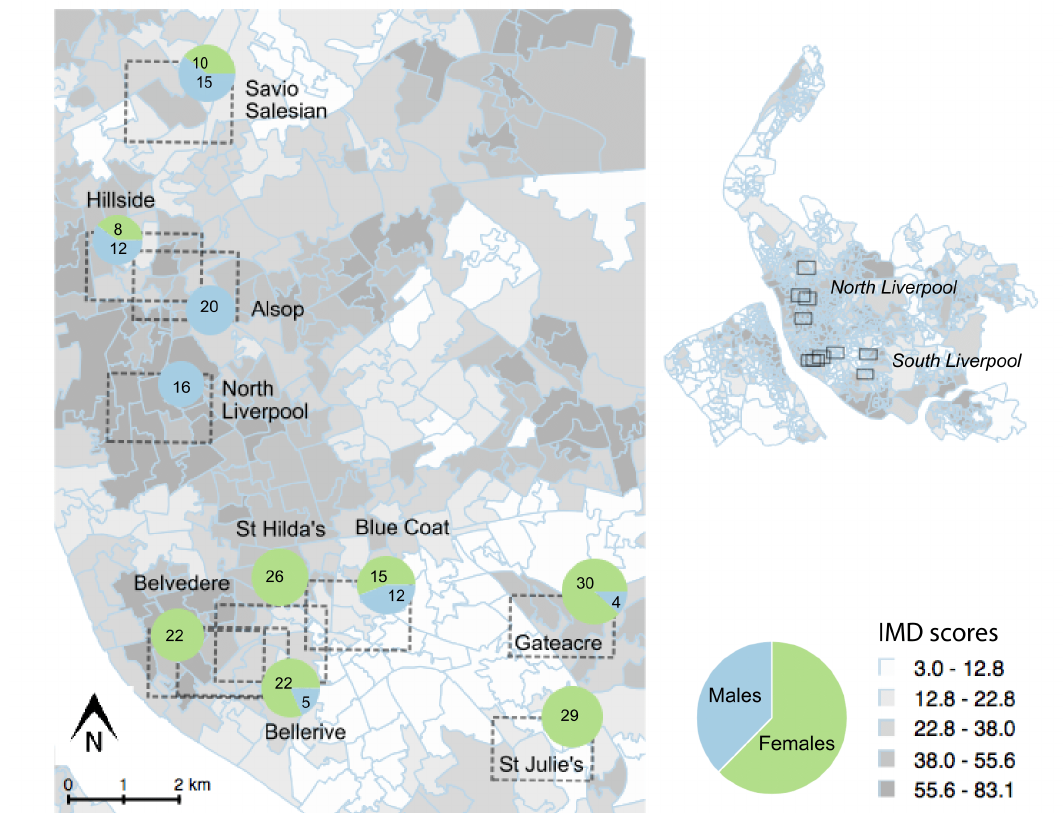
Figure 1. Locations of communities sampled over socio-economic status in Liverpool, UK (based on IMD; low-to-high values shown on a dark-to-light ramp). Pie graphs displaying number and distribution of participants in each workshop